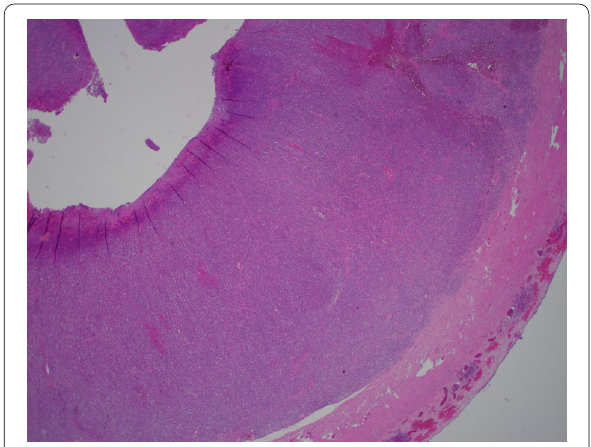
Fig. 5. 600 Magnification of appendiceal tissue with CD20 × immunohistochemistry staining